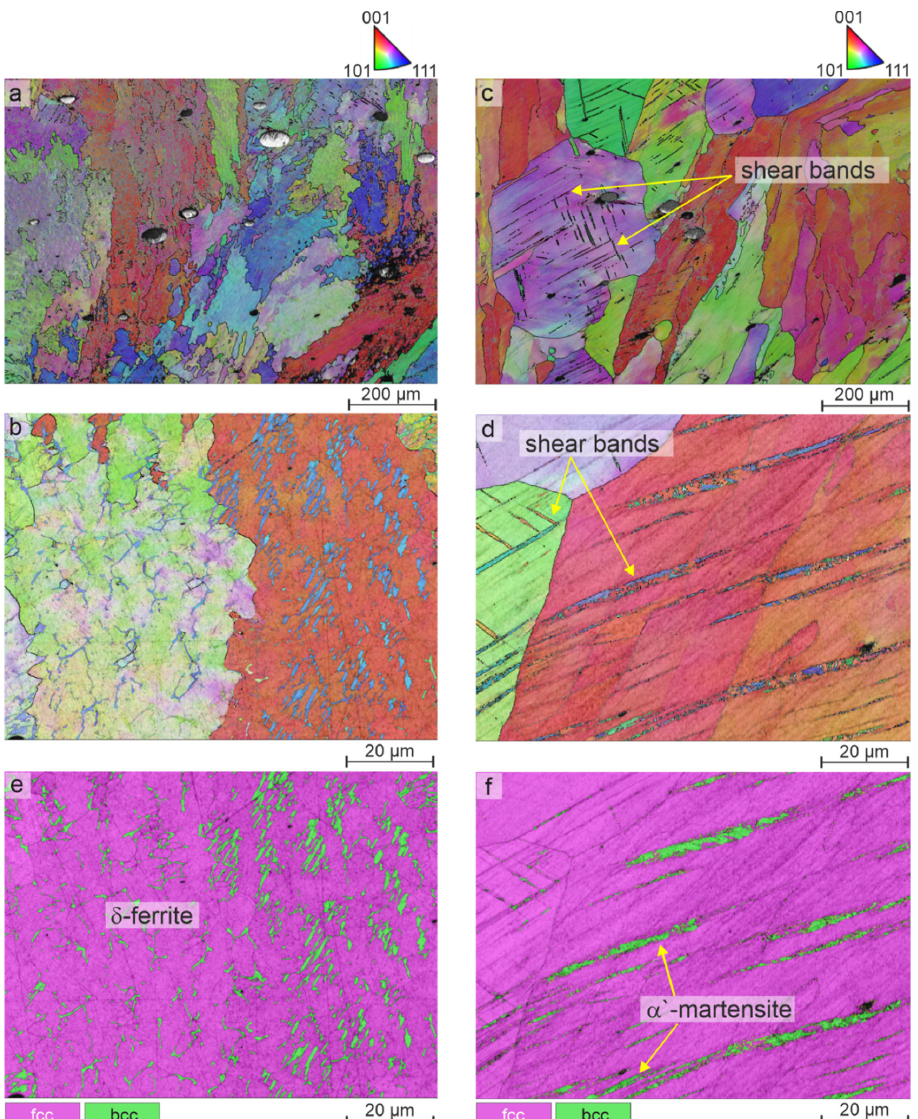
Figure 6. SEM-EBSD orientation maps of ( a ) coating of AISI 304 in as-cladded condition with ( b ) higher magnification image, ( c ) coating of AISI 304 after heat treatment at 1100 °C for 60 min with ( d ) higher magnification image; ( e ) phase map in as-cladded condition and ( f ) phase map after heat treatment at 1100 °C for 60 min.